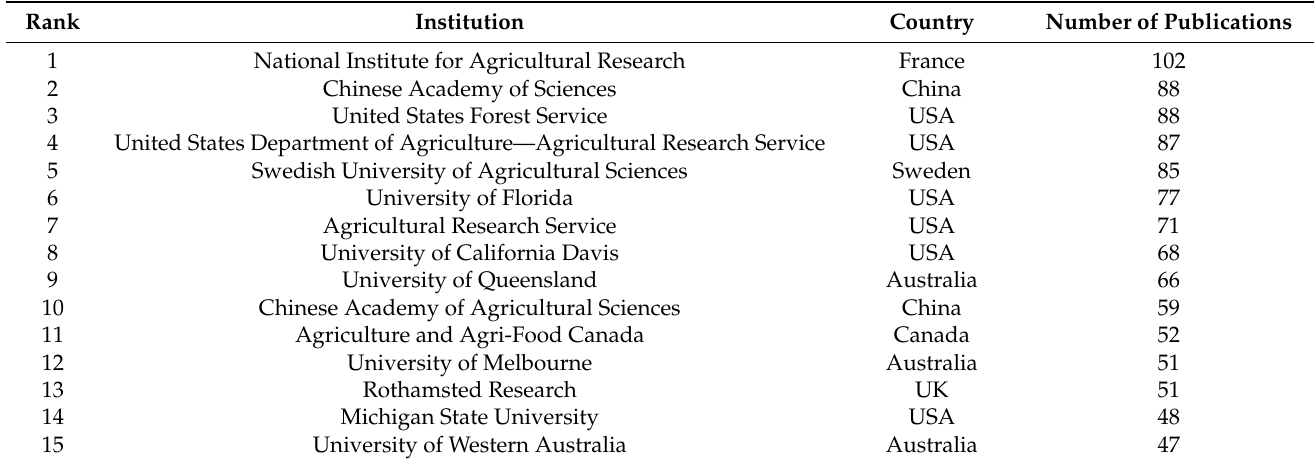
Table 4. Top 15 institutions in terms of number of published articles.